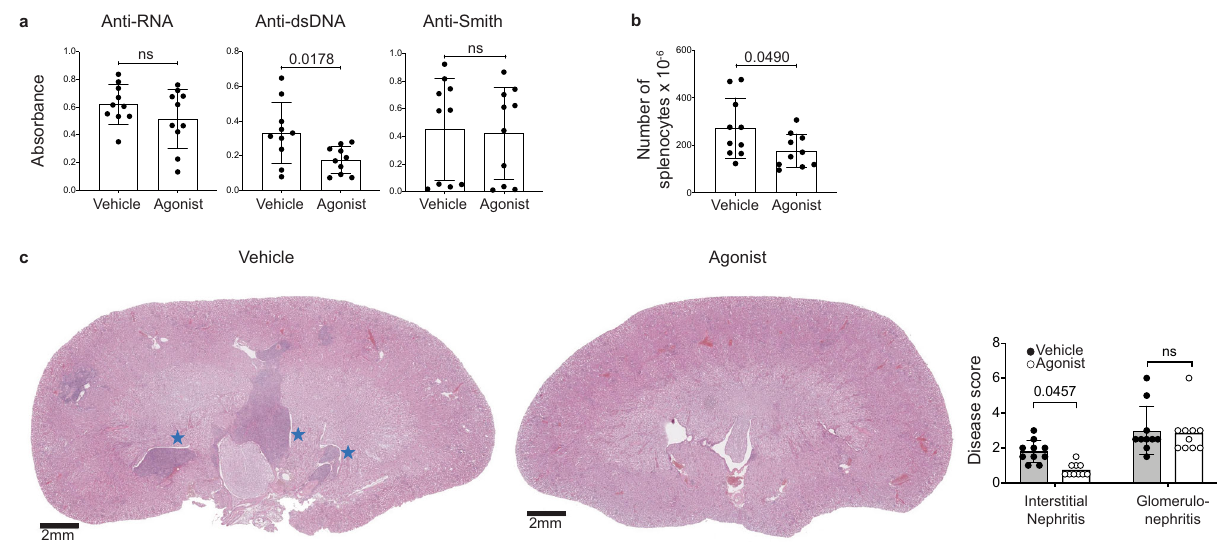
Fig. 5 A 2A receptor stimulation ameliorated disease in lupus-prone mice after disease onset. a Sera from the mice in Fig. 4a were analyzed for anti-RNA, anti-dsDNA, and anti-Smith antibodies by ELISA. The graphs show relative absorbance values for the analyzed sera. Statistical signi fi cance was determined using a two-tailed unpaired t -test (left and right graphs) or a Mann – Whitney test (middle graph). b The graph shows the number of splenocytes from the mice in Fig. 4a. Statistical signi fi cance was determined using a two-tailed unpaired t -test. c Kidneys from the mice in Fig. 4a were H&E-stained and were scored blindly for interstitial nephritis and glomerulonephritis. Representative sections are shown (1x magni fi cation). Lymphocyte and plasma cell aggregates are identi fi ed by blue stars. The graphs show the pathology scores. Statistical signi fi cance was determined using an ordinary two-way ANOVA with Sidak ’ s multiple comparisons test. Columns and error bars indicate the arithmetic mean and